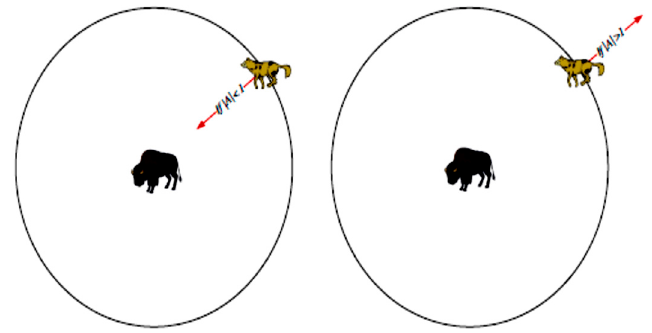
Figure 4. Convergence action and divergence action [13].